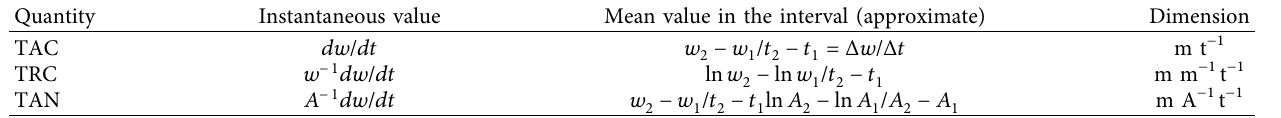
Table 1: Quantities associated with the analysis of growth in plants.